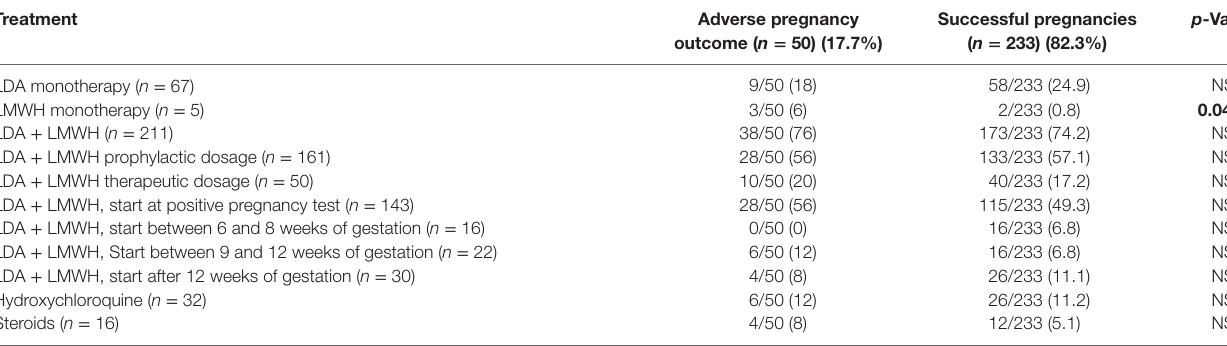
Table 8 | Comparison of treatment in successful and complicated pregnancy. Treatment